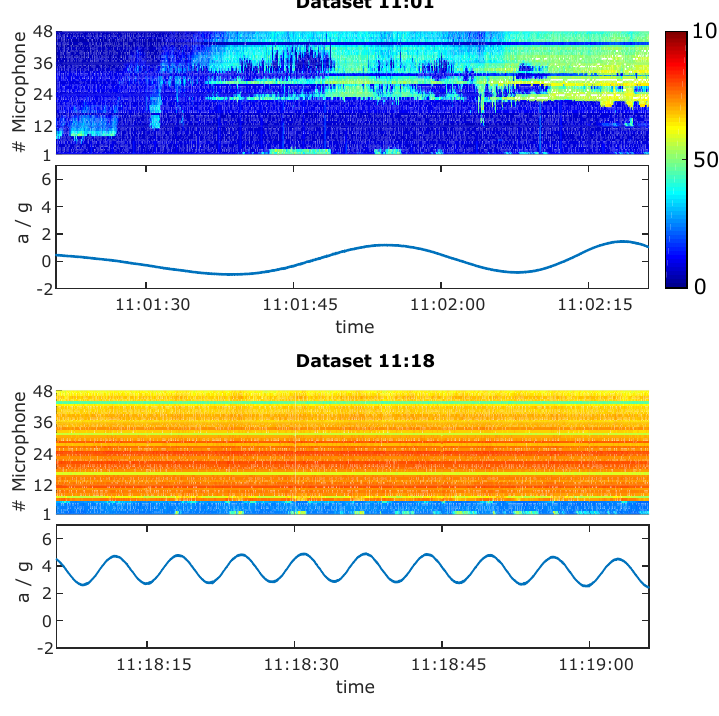
Figure 13. Detection of the transition position. ( Top ) SU; ( Bottom ) SS. ( Upper row ) Sound-pressure level (SPL) in Decibels (dB). ( Color map ) Dark blue corresponds to 0 dB and red to 80 dB. ( Lower row ) Local